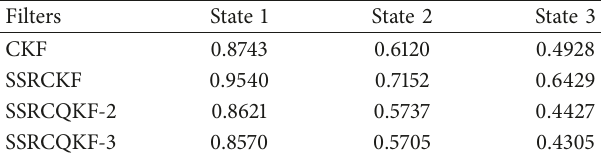
Figure 1: RMSE of state 1. Table 1: Average RMSE of state.